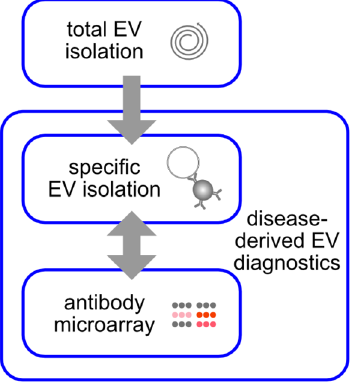
Figure 1. Workflow of the study. Comparing different total EV isolation methods for protein characterization to proceed with surface protein-specific EV capture from cell culture supernatant. The antibody microarray analysis of surface EV marker can serve as a tool to rapidly investigate targets for specific isolation. Selecting tissue- or disease-derived EVs can be applied in EV